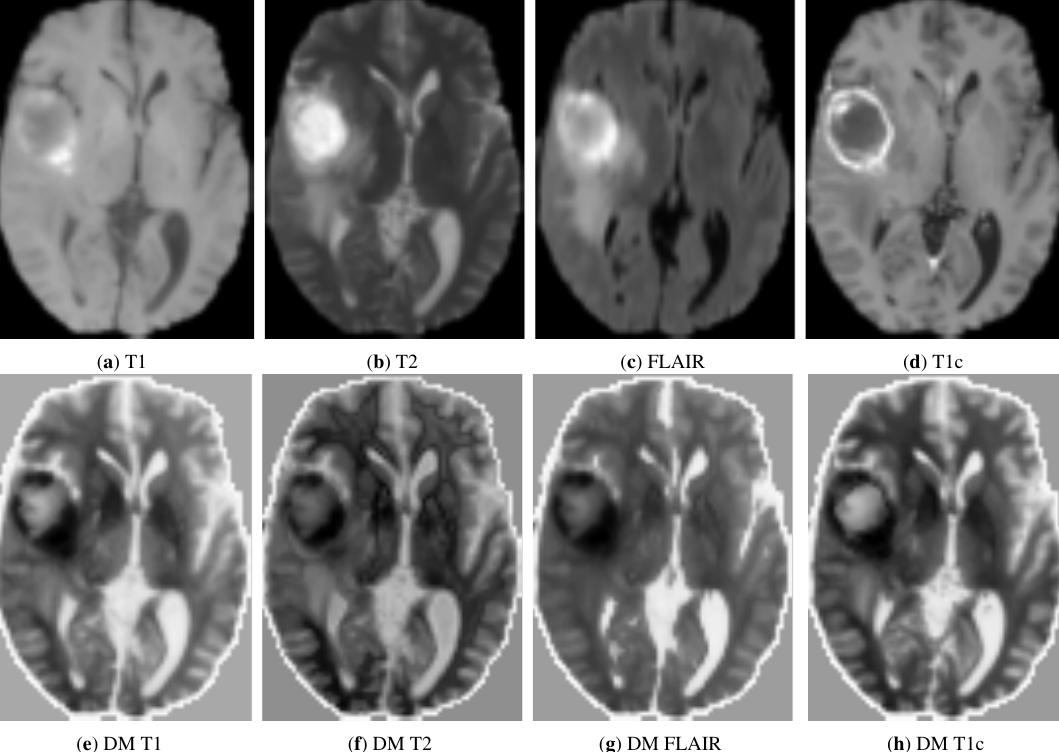
Figure 4. Example of multimodal images from the Brain Tumor Segmentation (BRATS) data set ( top row ) and their corresponding diffusion-map images ( bottom row